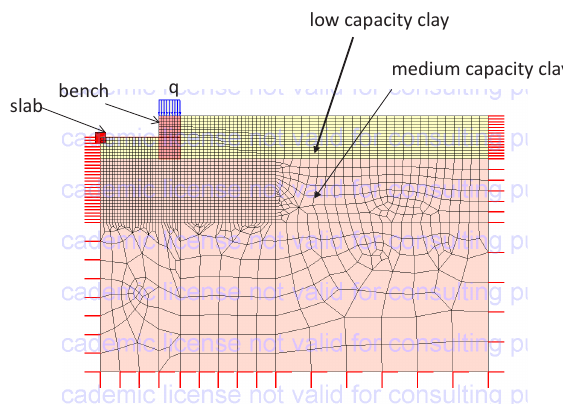
Figure 7: Example of the load—settlement curve, ultimate load reached.